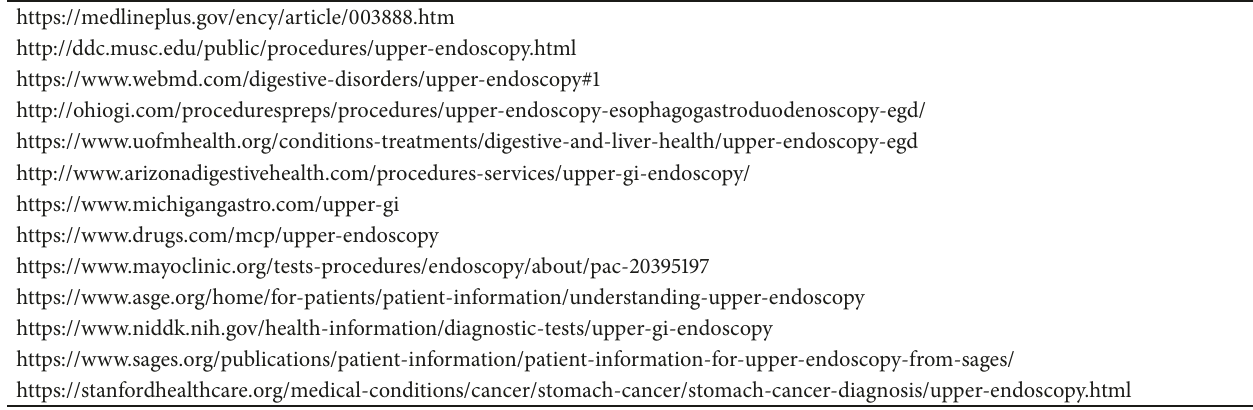
Table 5: Websites with moderate quality content on EGD (GQS of 4 or more).